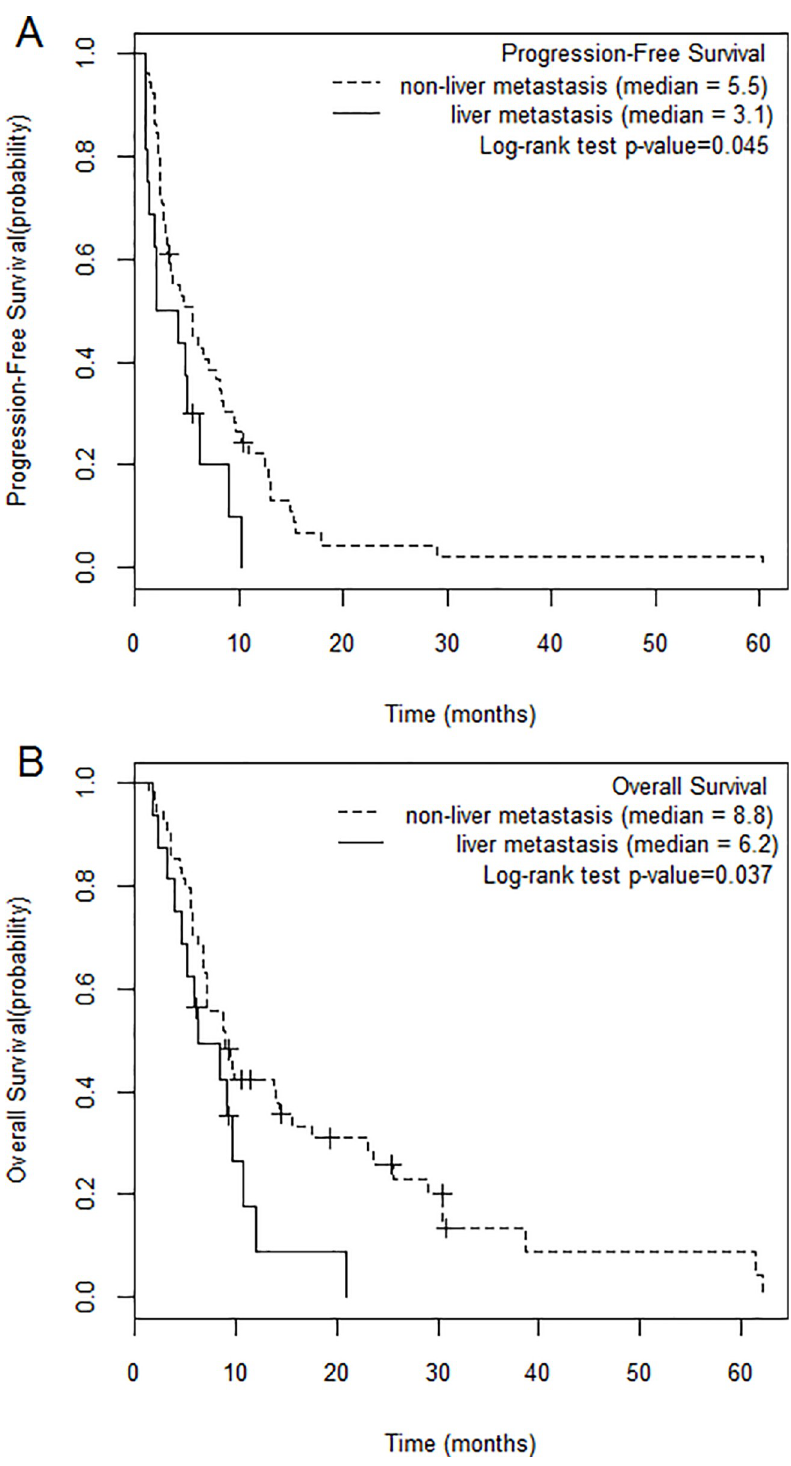
Fig 1. Kaplan-Meier curves of the relationship between liver metastasis and (A) progression-free survival and (B) overall survival.